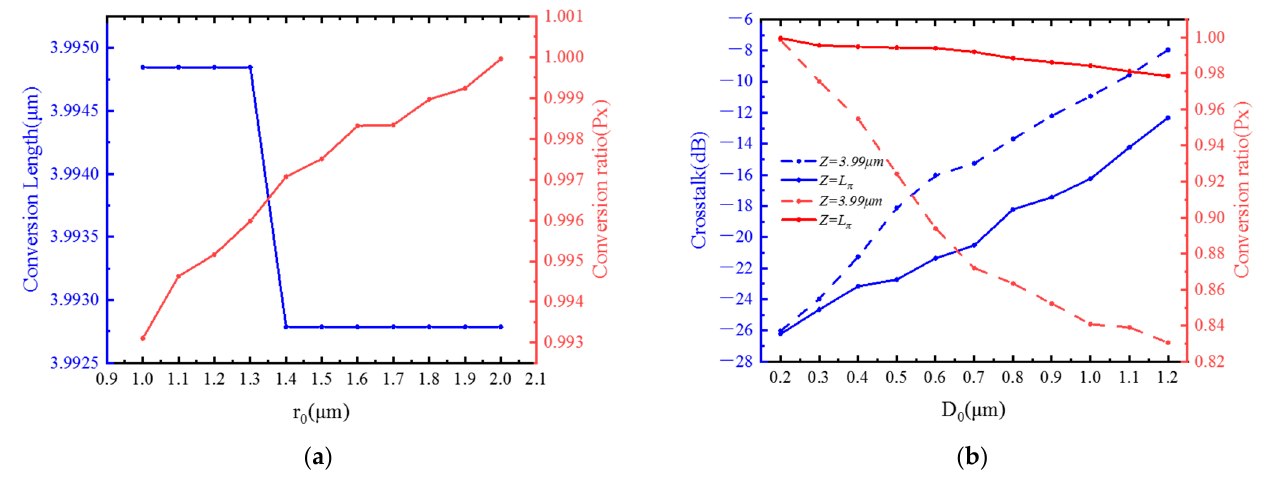
Figure 9. ( a ) Variations of conversion length and conversion ratio with the size of the air hole (r 0 ); ( b ) CT and conversion ratio at Z = L π and Z = 3.99 μ m with different values of the distance between the air pores and the core (D 0 ).